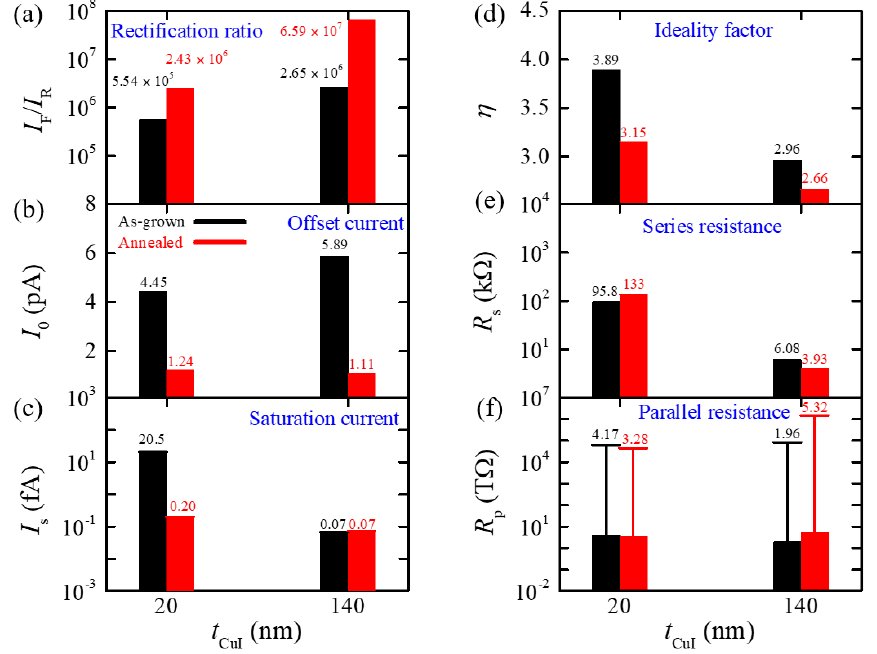
Figure 3. Summary of various diode parameters; ( a ) current rectification ratio I F / I R , ( b ) offset current I o , ( c ) reverse saturation current I s , ( d ) ideality factor η , ( e ) series resistance R s , and ( f ) parallel resistance R p . Black and red colors represent the data of the as-grown and annealed diode, respectively. All the parameters are estimated by fitting the results in Figure 2b,d with Equation (1). Error bars in ( f ) represent the least square fitting error. Error bars from the least square fitting were less than 5% for the other parameters ( b – e ).